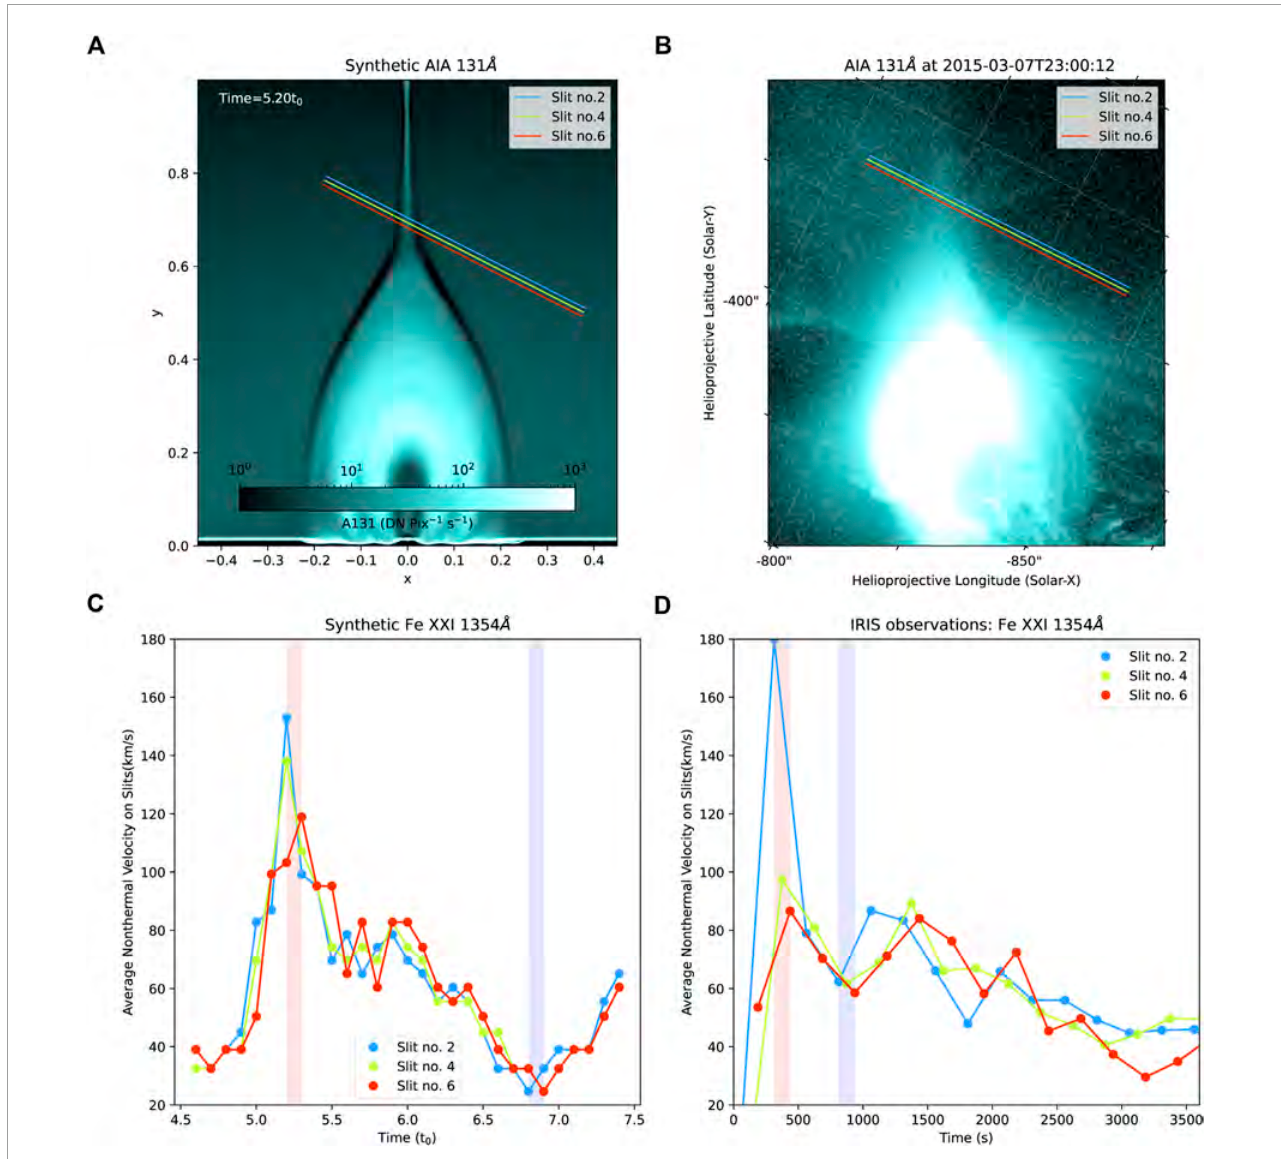
FIGURE 13 Modeled and observed non-thermal velocity of IRIS Fe XXI line. The left panels show: (A) the synthetic SDO/AIA 131 image, and (C) the non-thermal velocity calculated by using the averaged Fe XXI 1354 Å profiles along each IRIS slit. The colored solid lines in panels (A) and (C) indicate the IRIS slits with the length of ∼ 9 . 3 × 10 4 km (or ∼ 128 arcsec). The right panels (B) and (D) are for SDO/AIA 131 observations at 2015–03–07T23:00:12 and IRIS raster results, respectively. The start time on the horizontal axis in panel (D) is 2015-03–07T22:55:51. The red and blue shadowed regions display the evolution of the non-thermal velocity on different